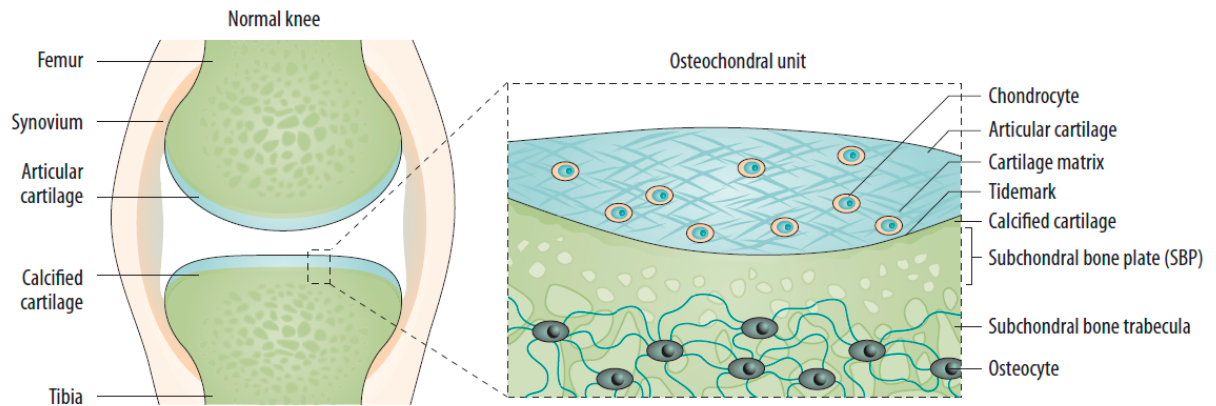
Figure 1. The normal joint—e.g., the knee—is composed of two articulating bones (femur and tibia), the articular cartilage, and the synovial lining of the joint cavity. A thin layer of calcified cartilage is present underneath the articular cartilage. The subchondral bone beneath the calcified cartilage is formed from cortical bone that merges into a network of trabecular bone, which is relatively porous and metabolically active. Source: original.